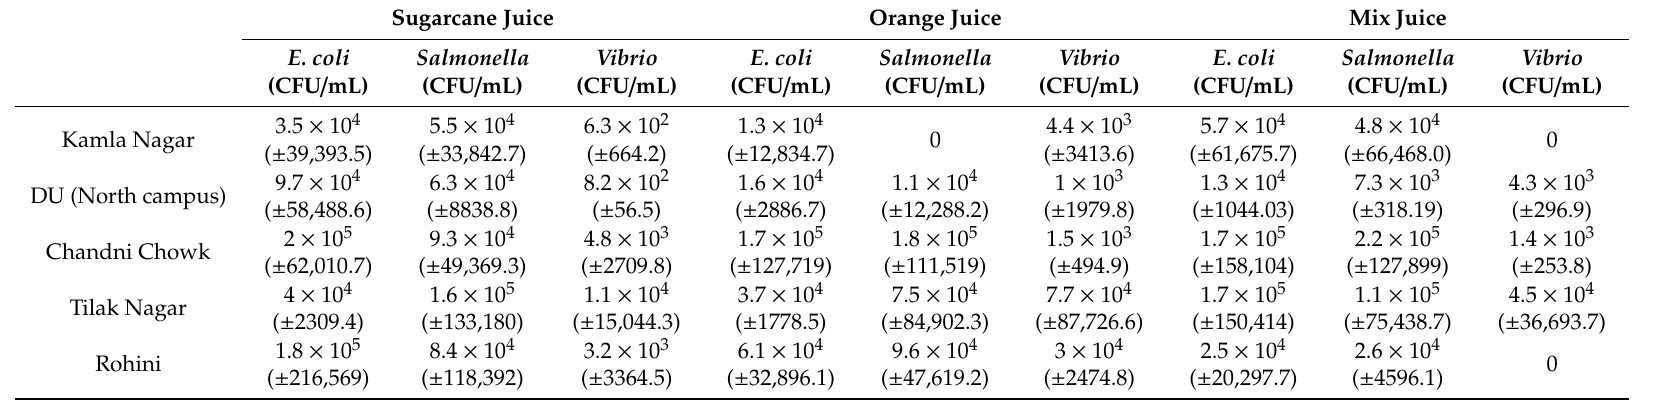
Table 2. Average total count (CFU / mL) of E. coli, Salmonella and Vibrio in fruit juices in five di ff erent